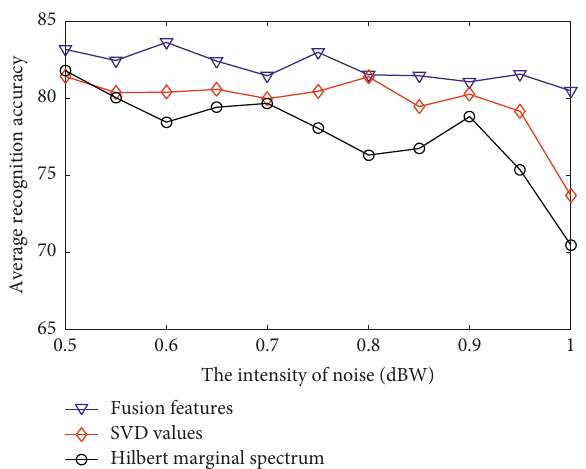
Figure 14: Recognition effect of different eigenvalues when noise signal of different intensities is added into excitation.